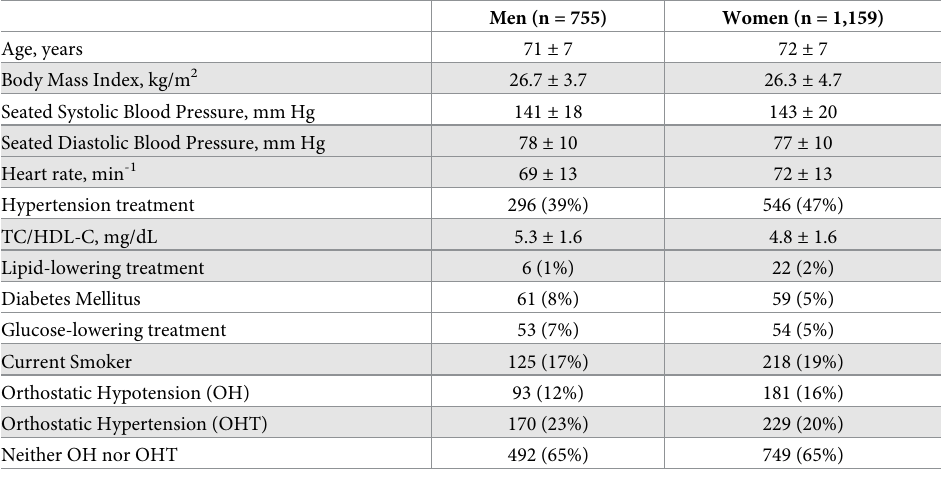
Table 1. Characteristics of study sample by sex.